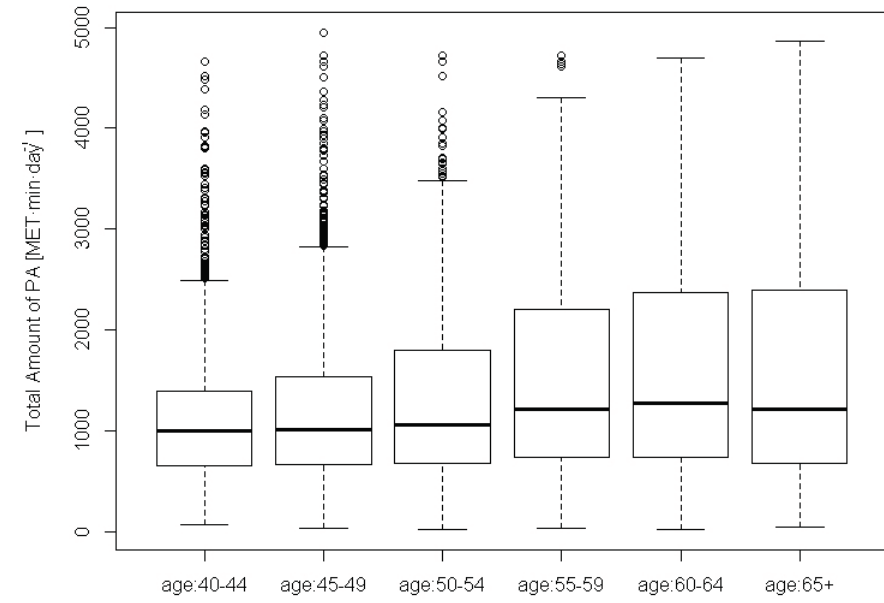
Figure 1. Box plots of total amount of physical activity (PA) by age group (40–44,